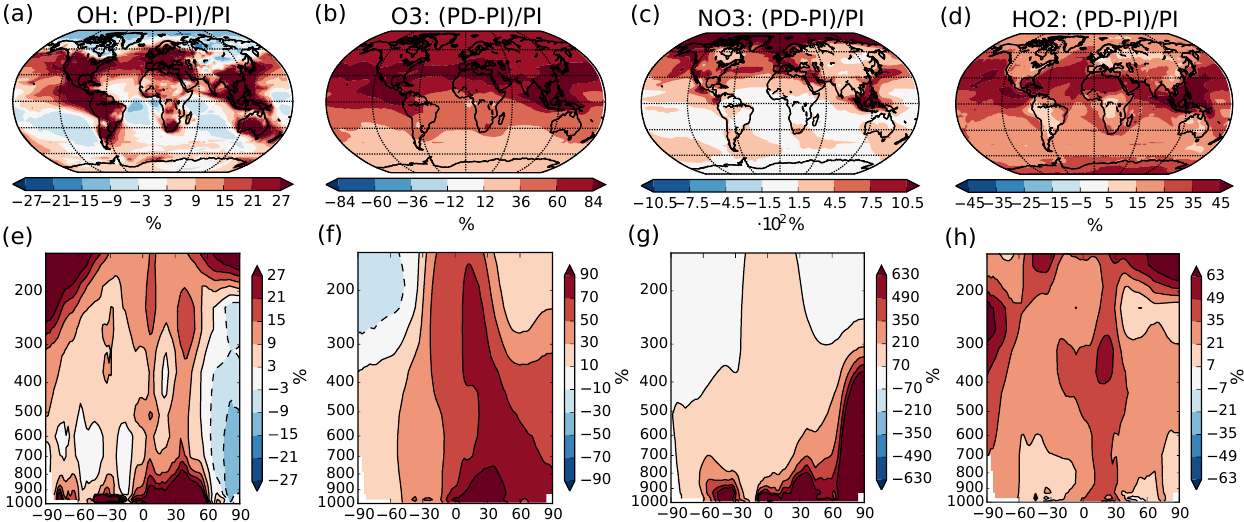
Figure 1. Percent-wise change in the annual mean oxidant mixing ratio (molmol − 1 ) between PI and PD in the dataset from Lamarque et al. (2010) used in this study. (a) – (d) Mean change from surface and up to 550hPa. (e) – (h) Zonal mean change. Please note the different scales on the color bars.